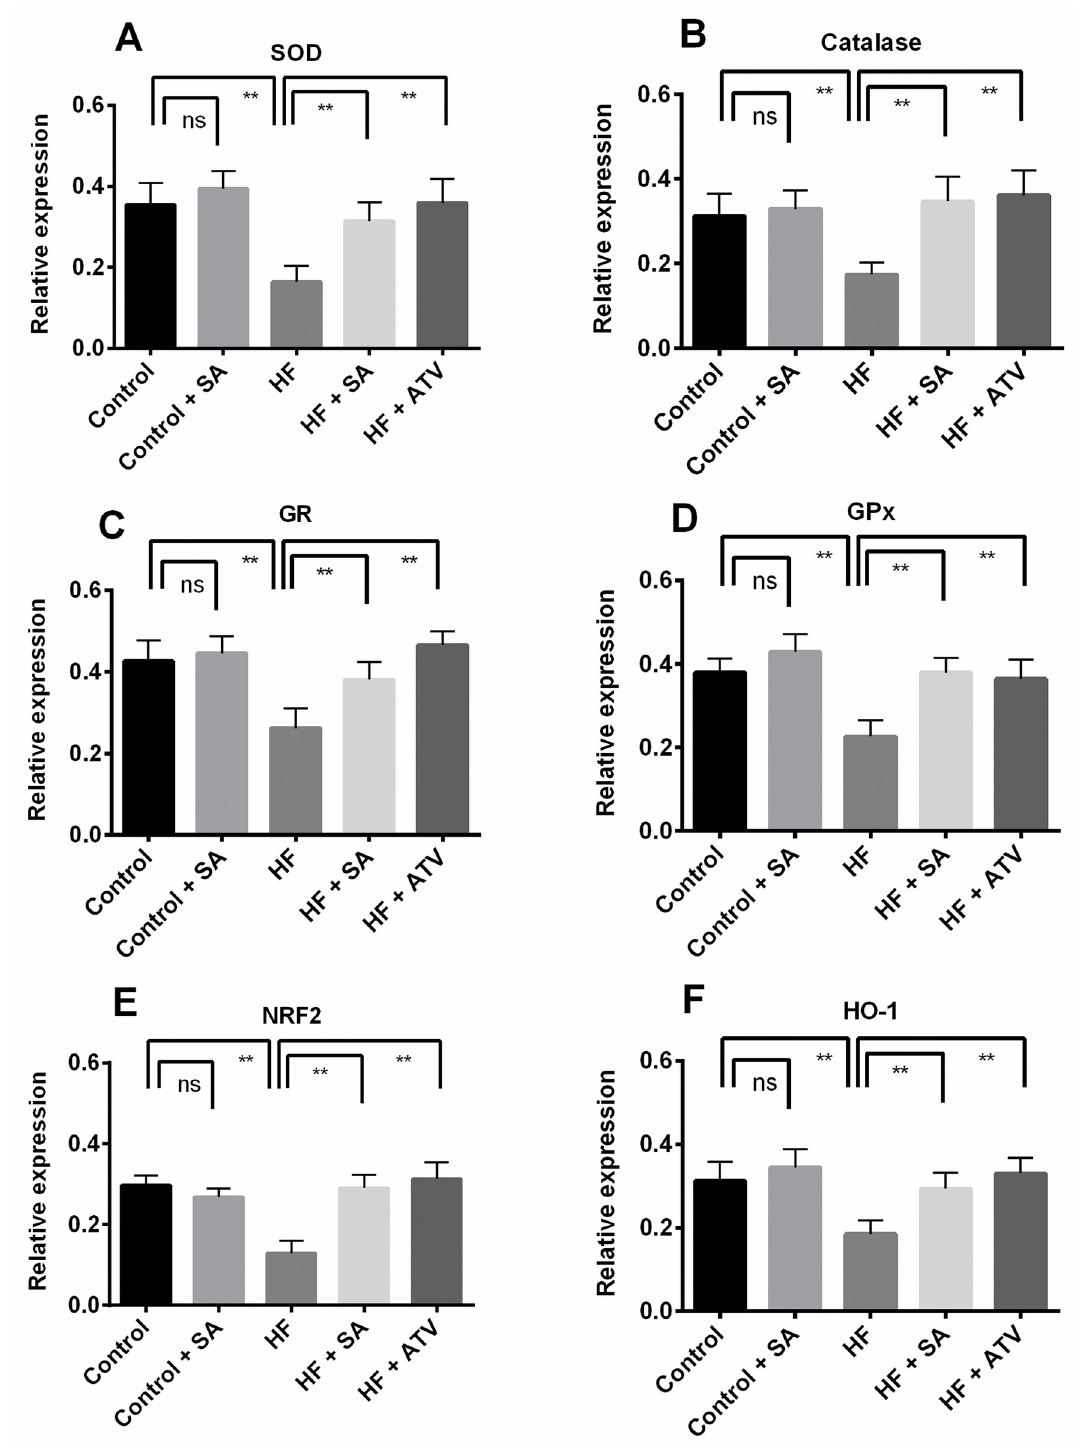
Fig 9. Effect of Senna alexandrina leaf powder supplementation on antioxidant enzyme activity genes expression in liver of high fat diet induced obese rats. Here, A. Super oxide dismutase (SOD); B. Catalase; C. Glutathione reductase (GR); D. Glutathione peroxidase (GP x ); E. Nuclear factor erythroid 2-related factor 2 (NRF 2); F. Heme oxygenase-1 (HO-1). Values are presented as mean ± SD, n = 6. One-way ANOVA followed by Tukey’s multiple comparisons test was done for statistical comparison. �� represents p �